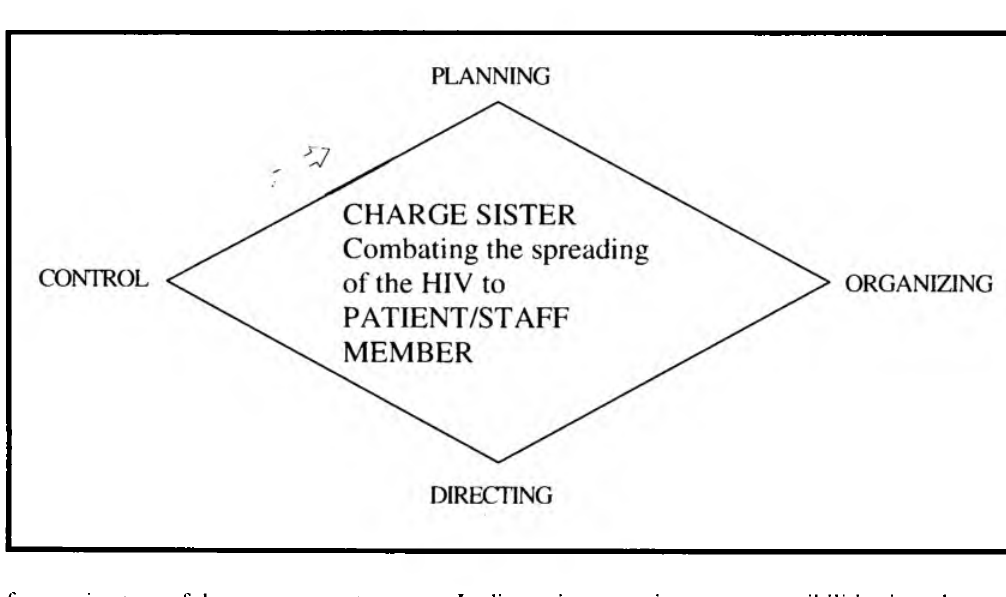
Figurel. The management process in prevention of the spreading of the